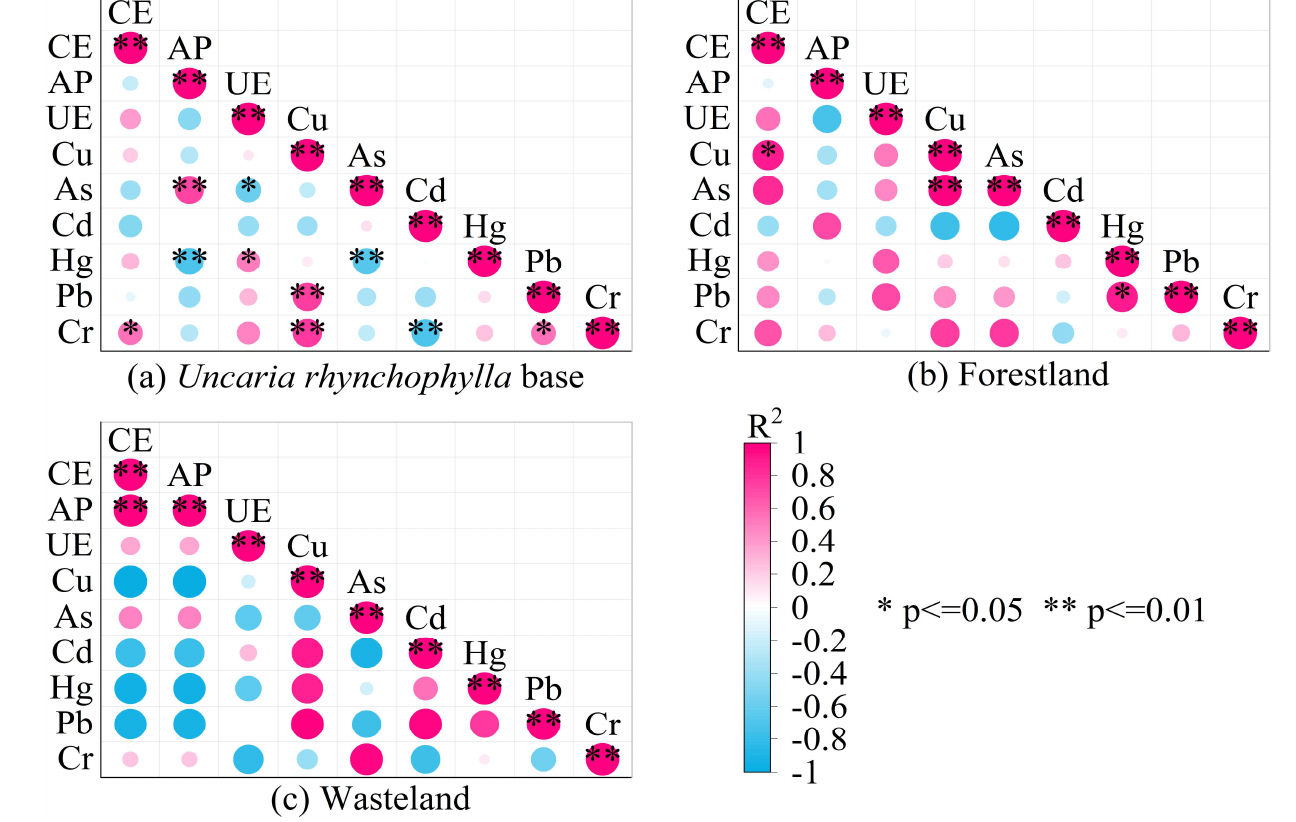
Figure 3. Relationship between soil heavy metals and enzyme activities under different land use patterns. Notes: CE, Catalase; AP, Acid Phosphatase; UE, Urease.